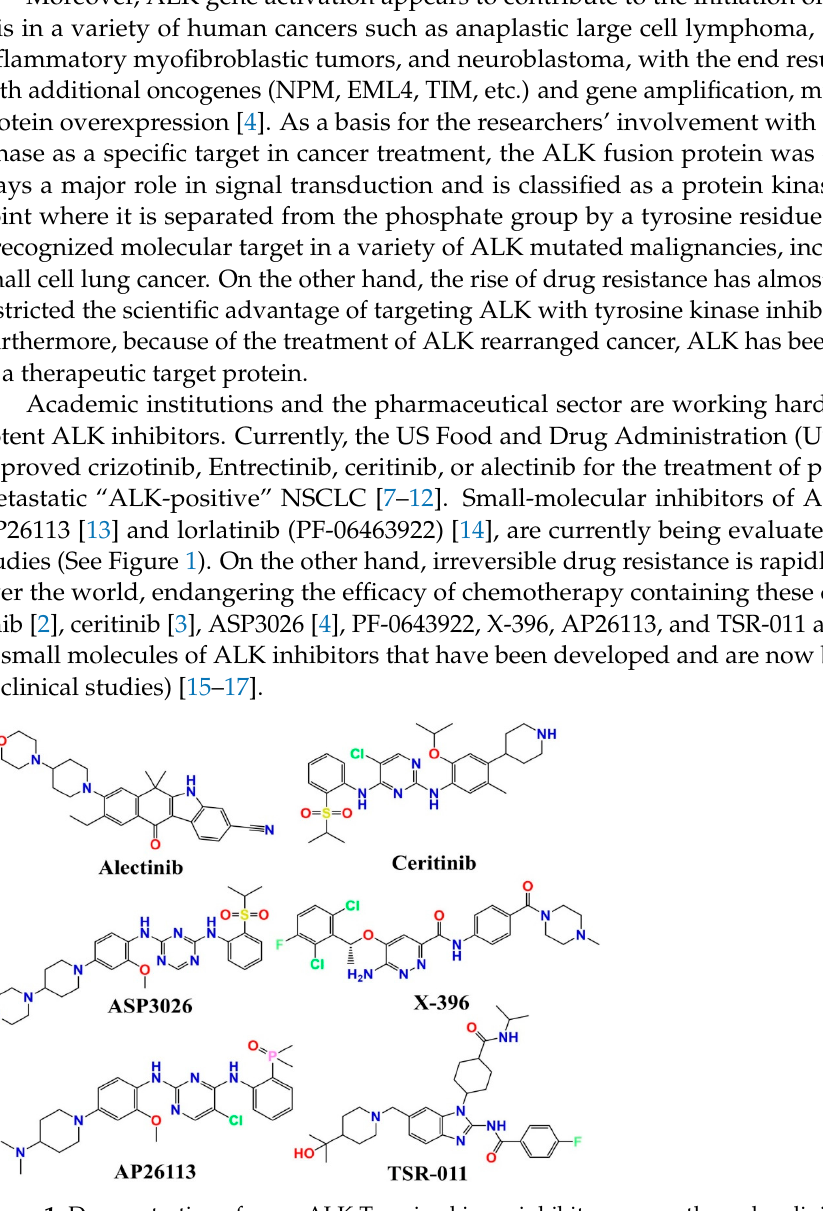
Figure 1. Demonstration of some ALK Tyrosine kinase inhibitors presently under clinical trials.